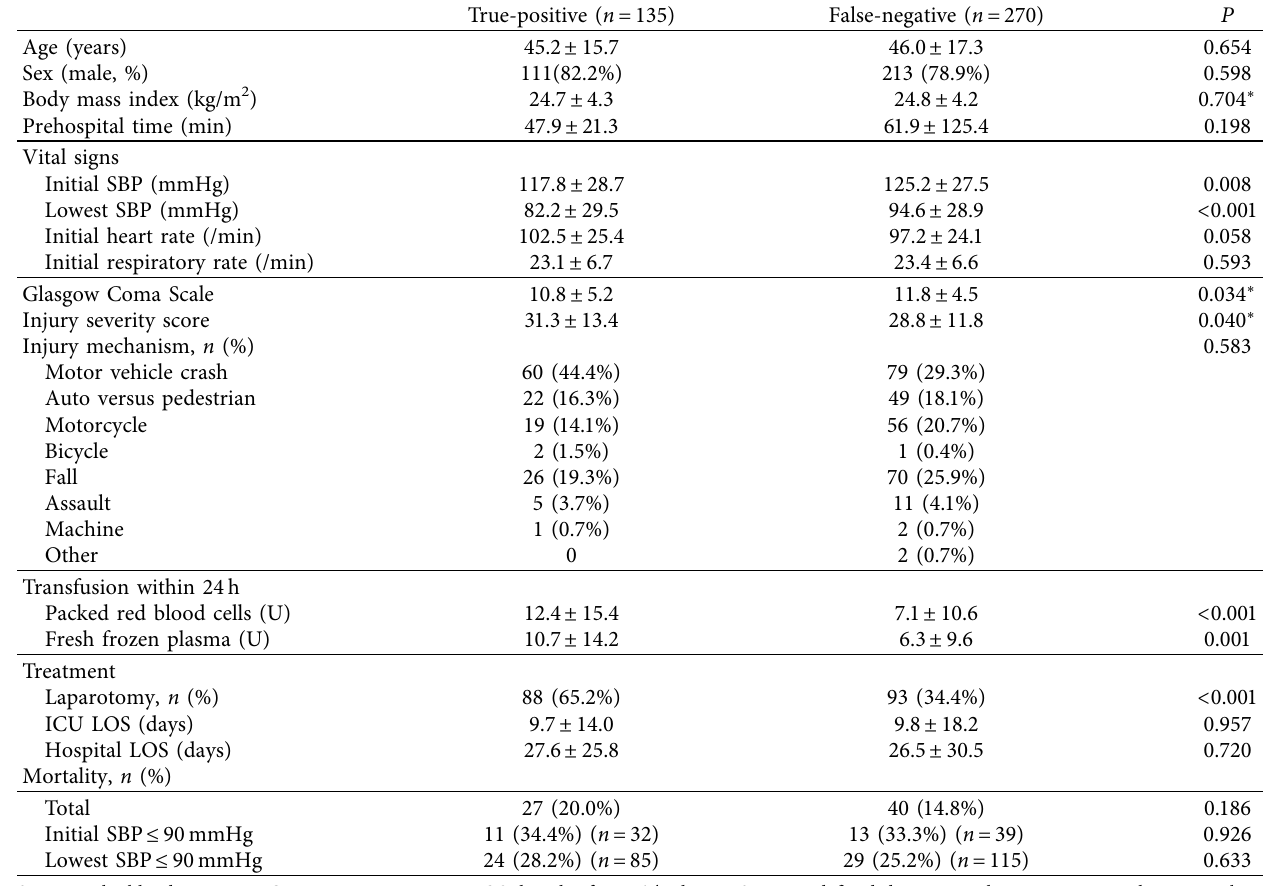
Table 2: Patients’ characteristics and outcomes.